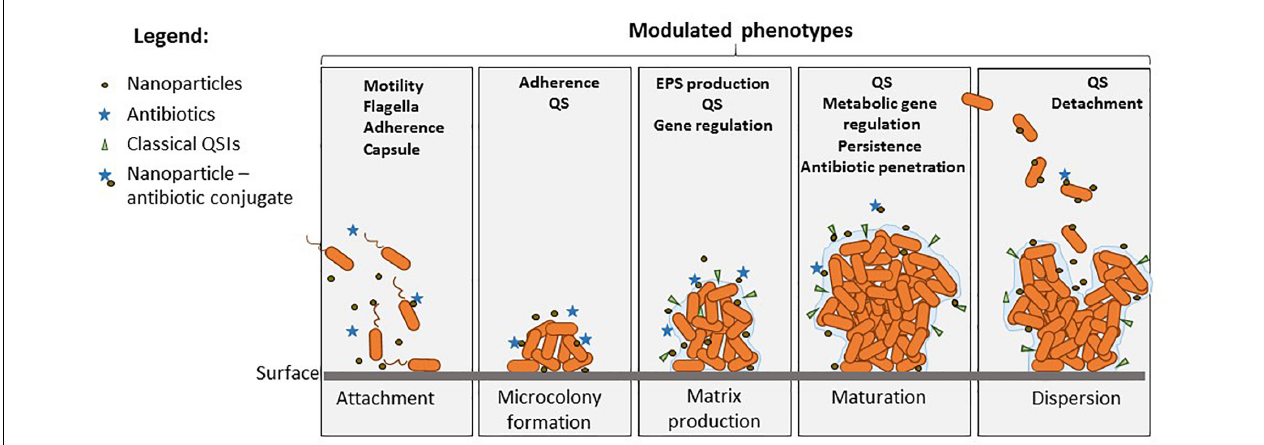
FIGURE 4 | Overview of the modulated phenotypes in biofilms produced by Acinetobacter , Klebsiella , and Enterobacter , which could be modulated by diverse QS modulators, NPs, and antibiotics. Nanoparticles can inhibit the attachment and early biofilm development, being also able to deliver antibiotics, QSIs, and other bioactive molecules in the biofilm. Phenotypes such as motility and attachment are modulated by such molecules, and this controls biofilm initiation. Maturation is influenced by EPS inhibition and QS interference, which also impacts the metabolic changes in the biofilm such as stress response, tolerance, and persistence. Finally, dispersion of mature biofilms could be also controlled by some molecular inhibitors controlling cell